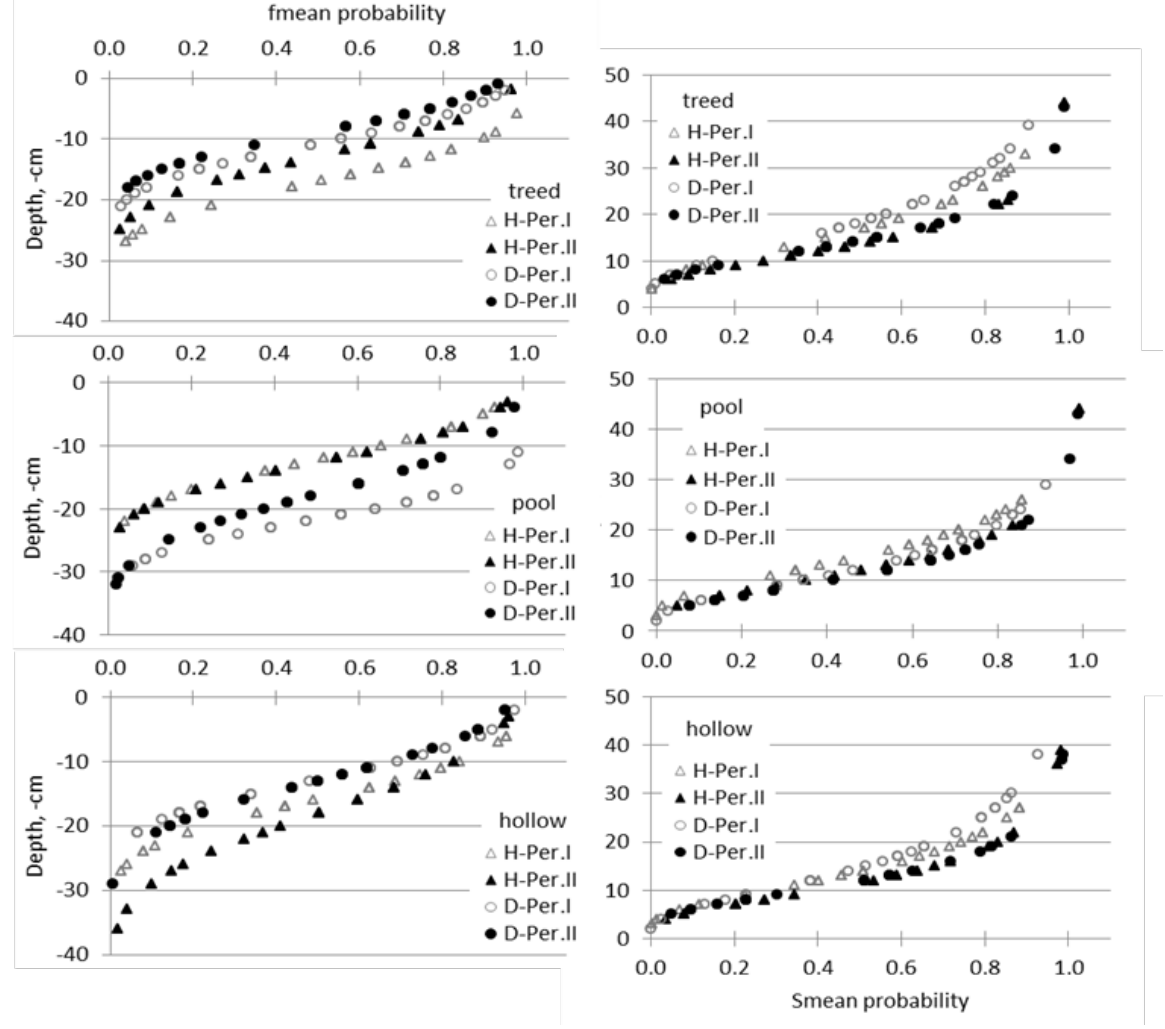
Figure 8. PBPs of the Period I (Per.I) and Period II (Per.II) soil frost (f recorded at hummock (H) and depression (D) microforms of the Männikjärve treed, ridge-pool and ridge- hollow